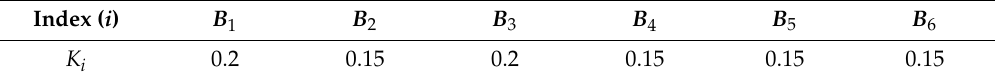
Table 3. The K i assigned to each